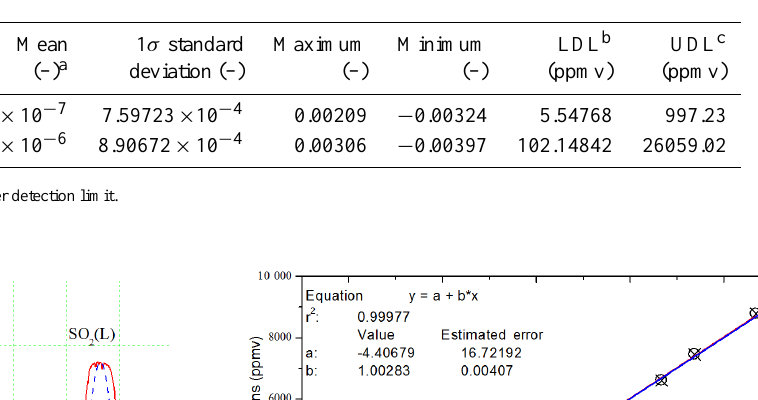
Table 4. Statistical results for the absorbance time series in Fig. 6; the corresponding estimation results for measurement range are also included. Ten measurement cycles are averaged, resulting in a temporal resolution of approximately 4s per reading.